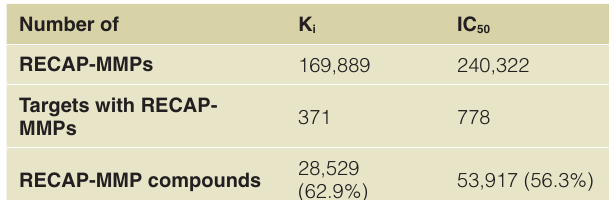
Table 4. RECAP-MMP